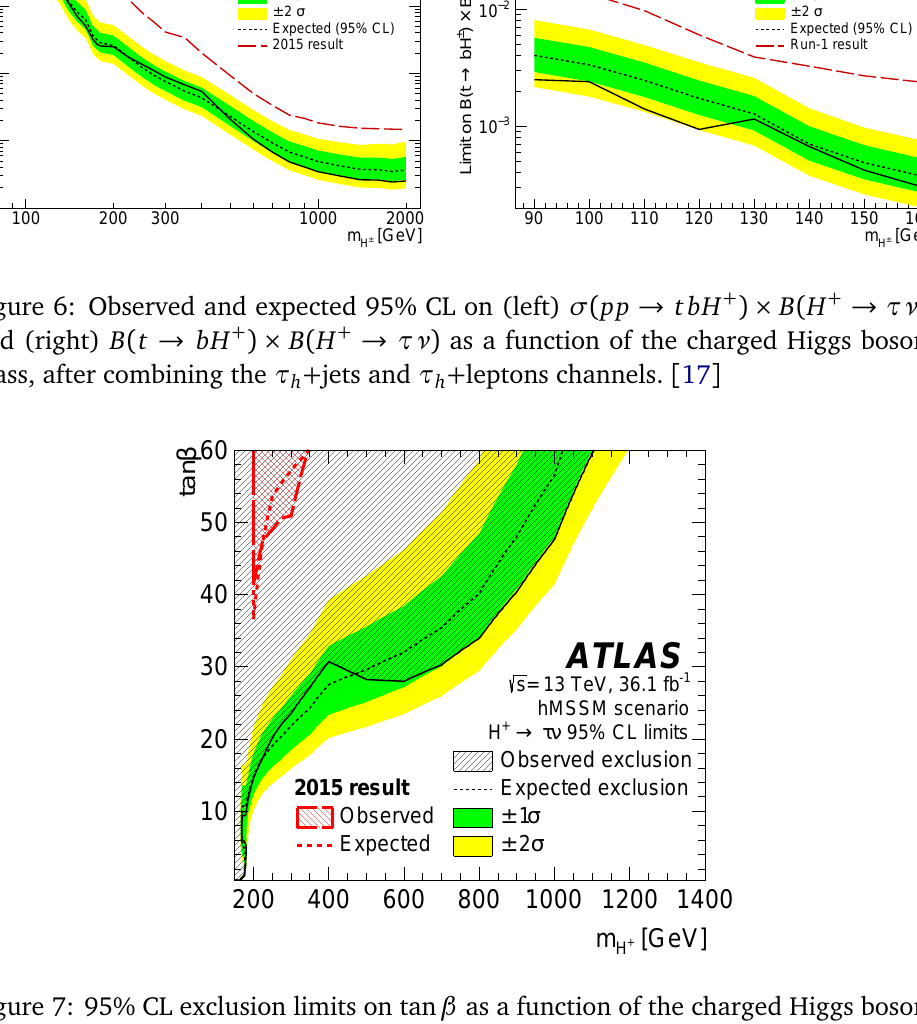
Figure 7: 95% CL exclusion limits on tan β as a function of the charged Higgs boson mass in the context of the hMSSM scenario, for the regions in which theoretical predictions are available ( 0.5 ≤ tan β ≤ 60 ) . [ 17